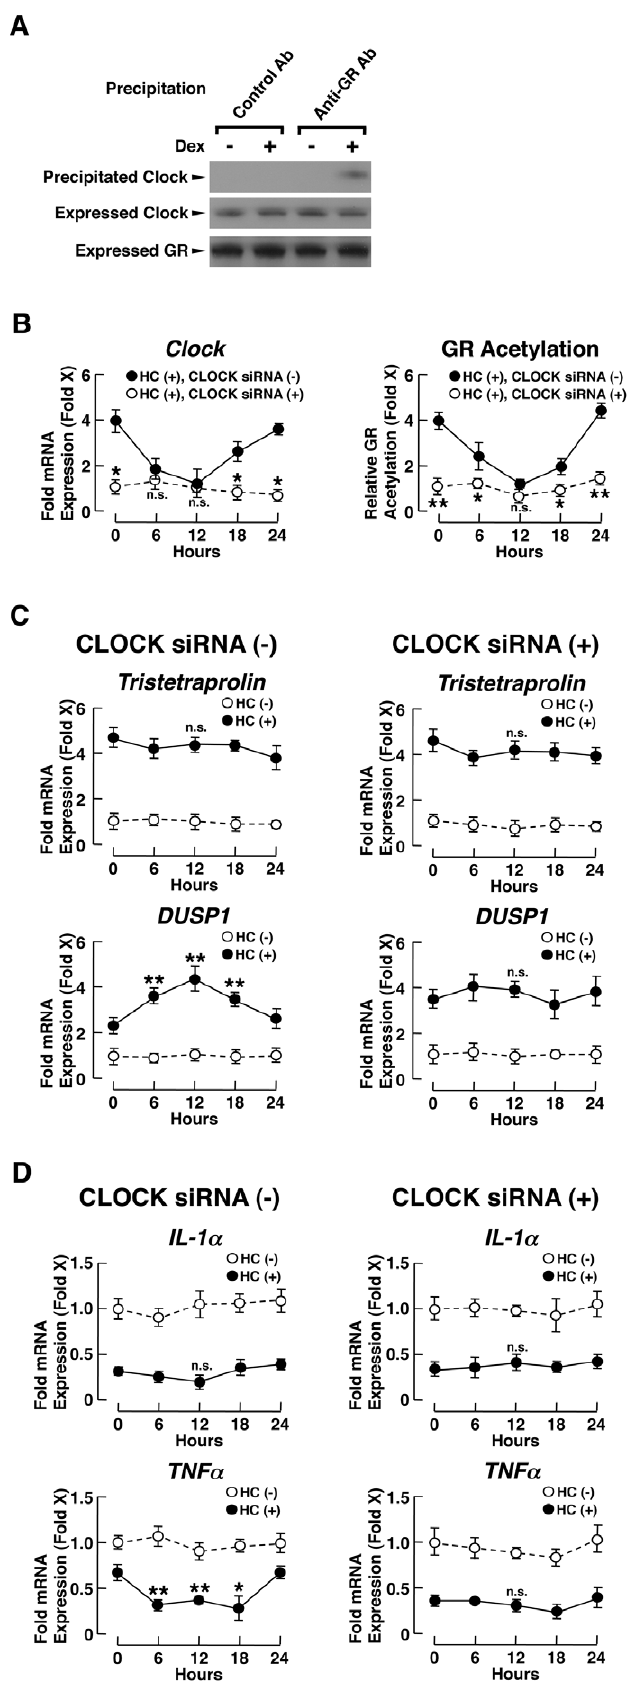
Figure S1 Response of glucocorticoid-responsive gene mRNA expressions to hydrocortisone in EBV-transformed peripheral lymphocytes and their daily changes in PBMCs. A: The effect of hydrocortisone on the expression of the mRNAs of known glucocorticoid-responsive genes in EBV-transformed peripheral lymphocytes. Samples obtained as in Figure 3 were used for the